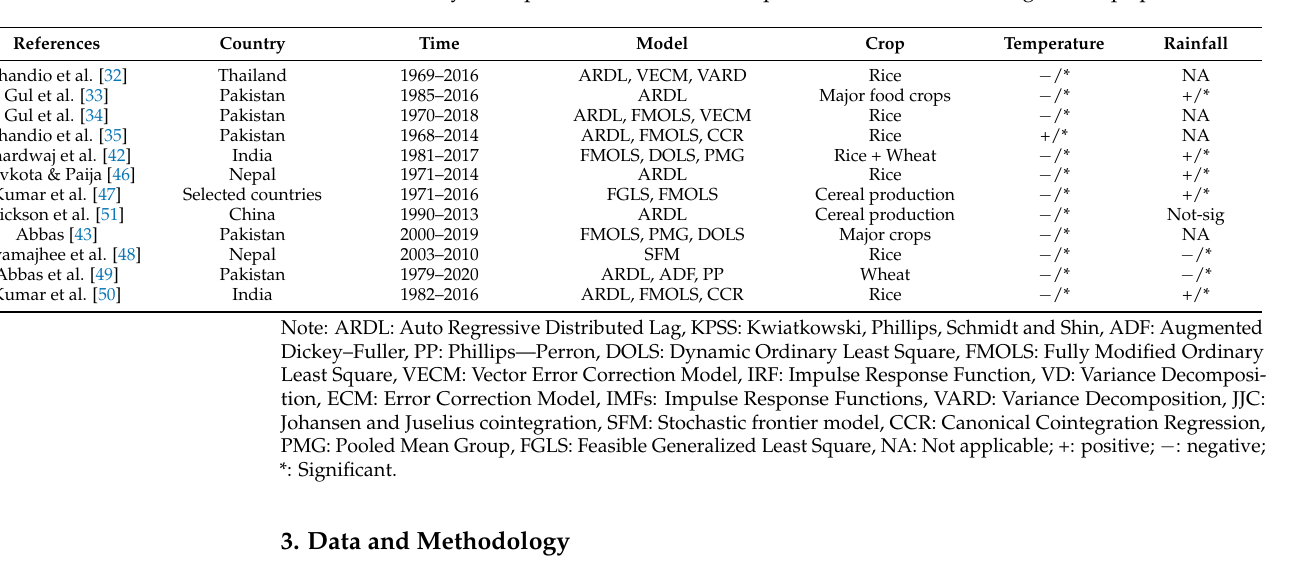
Table 2. Summary of empirical studies on the impact of climatic factors on grain crops